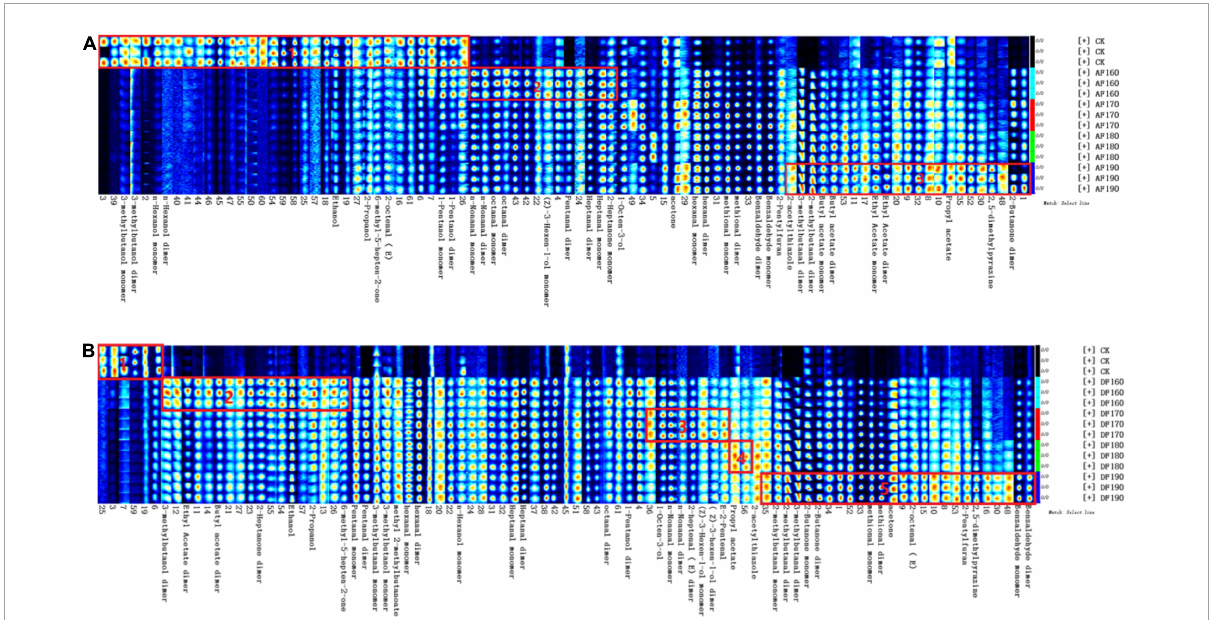
FIGURE4 Effect of frying temperature on the volatile flavor compounds of AFSM (A) and the volatile flavors of DFSM (B) . DF, shrimp meat was treated with deep frying; AF, shrimp meat was treated with air frying; 160, 170, 180, 190: The fried temperature of shrimp meat is expressed as 160, 170, 180, and 190 ◦ C.